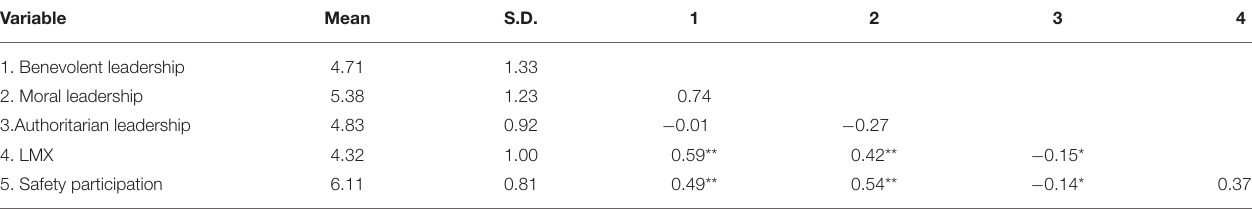
TABLE 2 | Descriptive statistics, correlations, and reliabilities for study variables. Variable